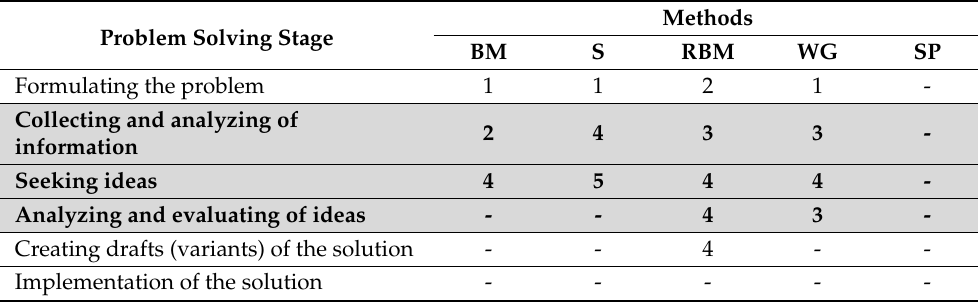
Table 2. Usability of selected inventive methods broken down by problem-solving stages (own work based on